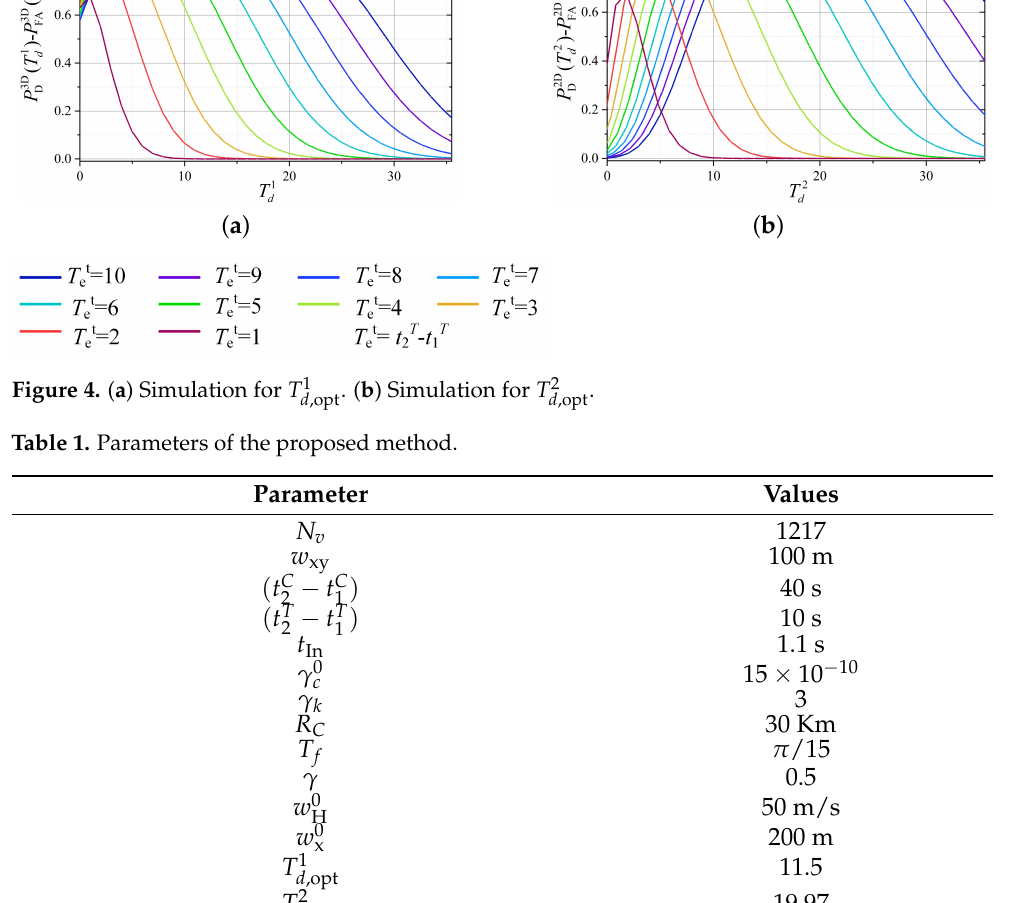
. ( b ) Simulation for T 2 d ,opt